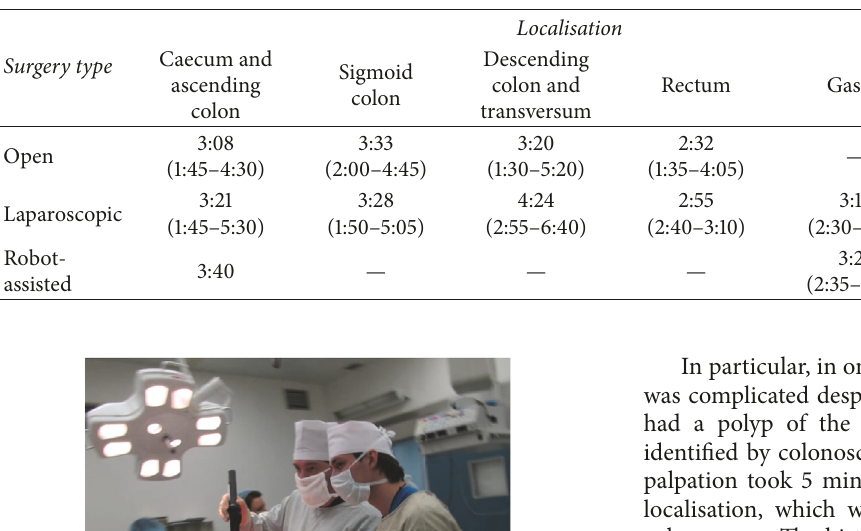
Table 4: Duration of instrumental mechanoreceptoric palpation. The mean values are presented (minutes:seconds), along with the minimum and the maximum values (where applicable).